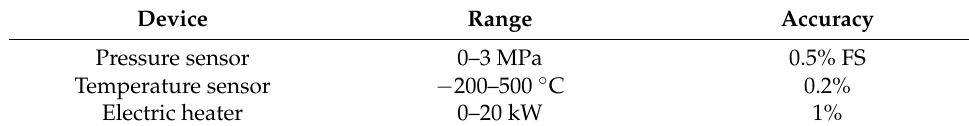
Figure 6. Device layout for the compressor test system.